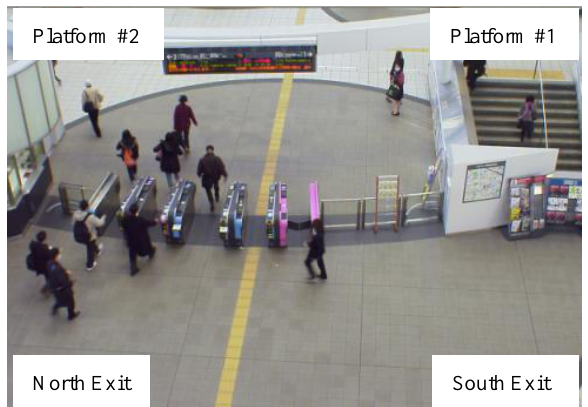
Figure 5. Example of obtained